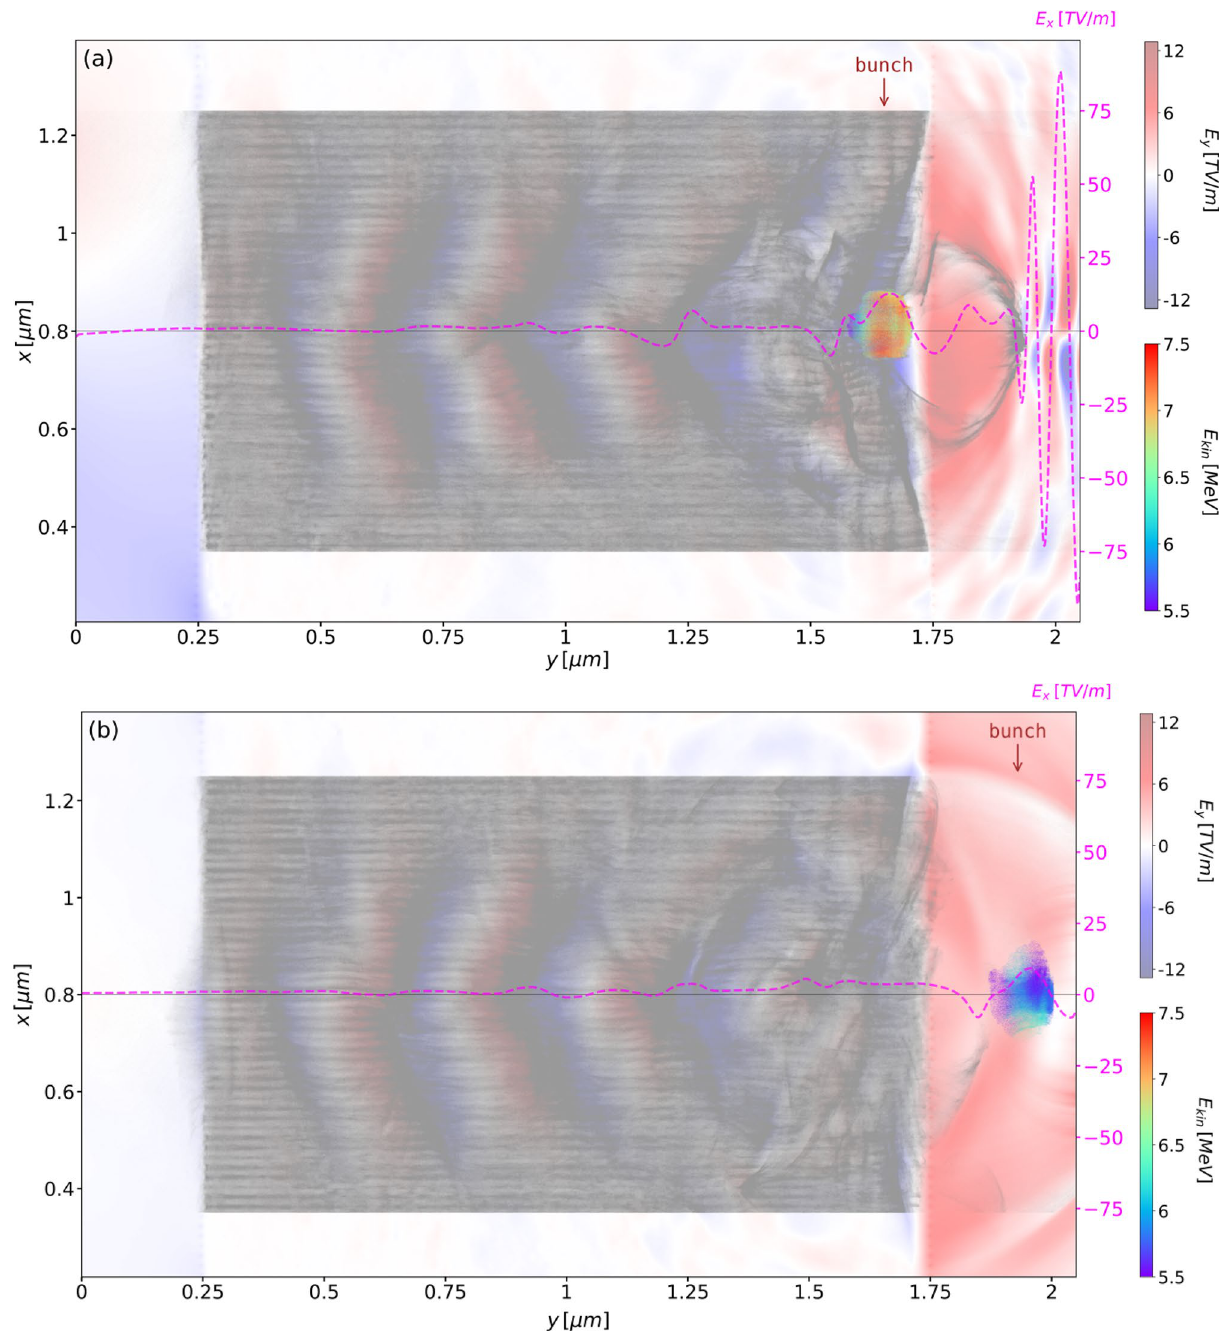
Figure 8. Electron macroparticles shown at: ( a ) t / T = 27 and ( b ) t / T = 30, for the target (grey dots) and for the accelerated bunch (rainbow-coloured dots with the colour map representing the kinetic energy). The laser pulse is shown through the on-axis transverse electric field E x (dashed purple line). It depletes the layers of electrons, building up regions of negative and positive longitudinal electric field (red-blue colour